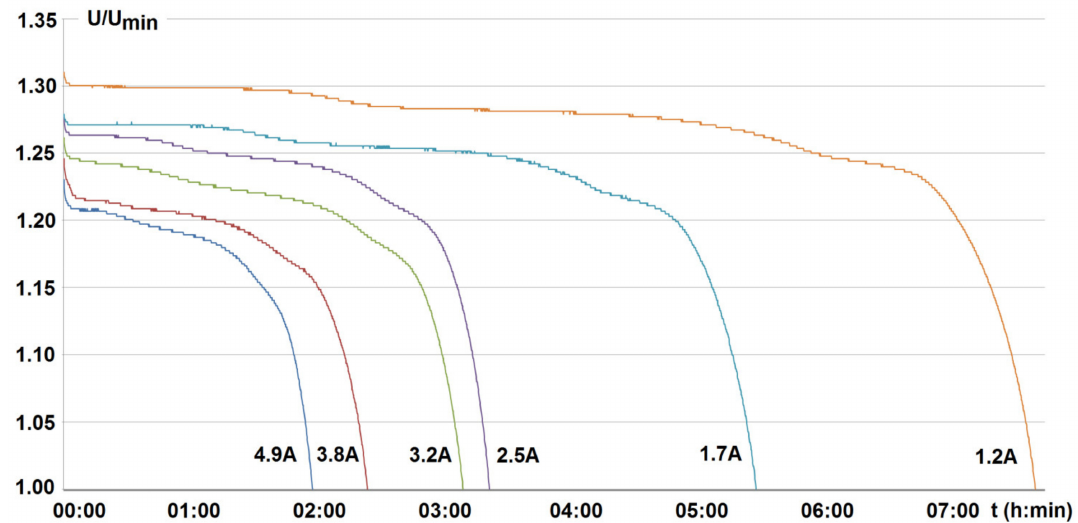
Figure 10. Variation of cell voltage U with time versus the load current (1.2–4.9 A) for a constant ambient temperature (about 22 ◦ C). U min = 2.5 V.